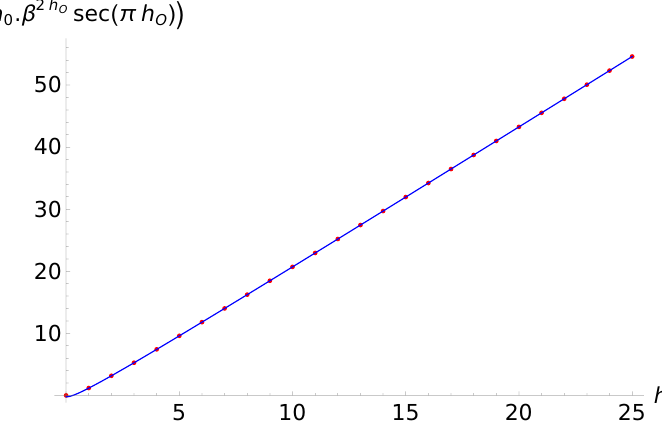
Figure 4 . The blue curve represents the plot of the function log[ a 0 β 2 h O sec( πh O )] , where a 0 is obtained from the result of our saddle point analysis given in the equation (5.61). The red points are the exact values of the log[ a 0 β 2 h O ( − 1) h O ] at the integer values of h O obtained by explicitly evaluating the residue